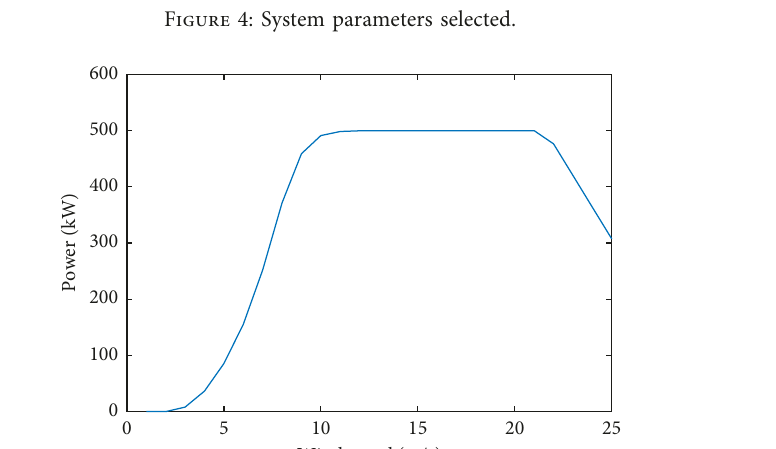
Figure 5: Wind turbine power curve (500kW). Table 4: Smart appliances’ power